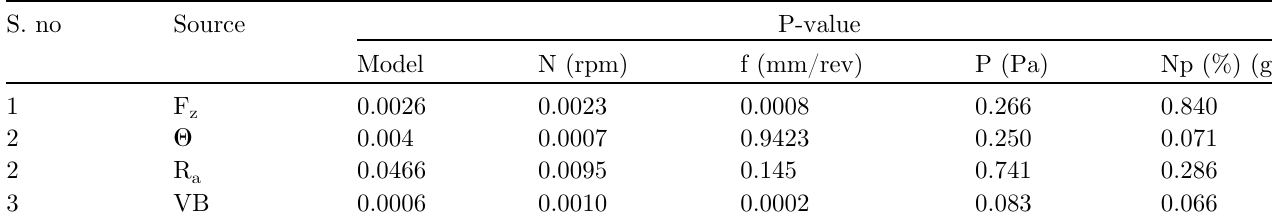
Table 6. ANOVA (P-value) table for the responses.